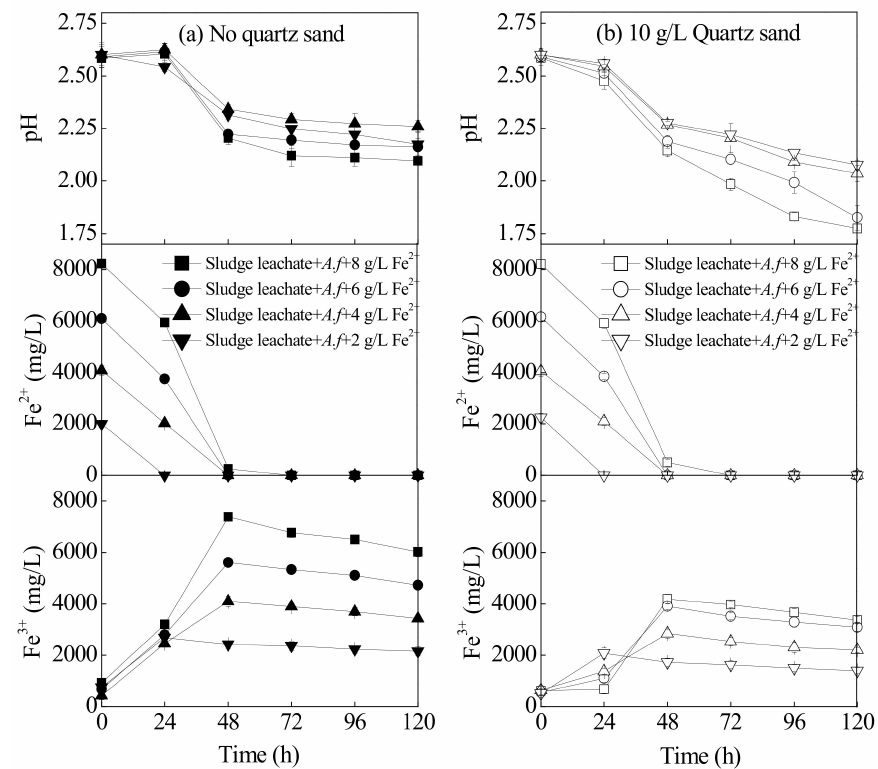
Figure 3. The index change (pH, Fe 2+ and Fe 3+ concentration) in the municipal sewage sludge with different treatments at 28 ◦ C and 180 rpm for 120 h: ( a ) no quartz sand; ( b ) 10 g · L − 1 quartz sand (initial pH = 2.55, Fe 2+ concentration = 2–8 g · L − 1 , sludge leachate volume = 270 mL, A. ferrooxidans LX5 volume = 30 mL, A. ferrooxidans LX5 density = 5 × 10 7 cells · mL − 1